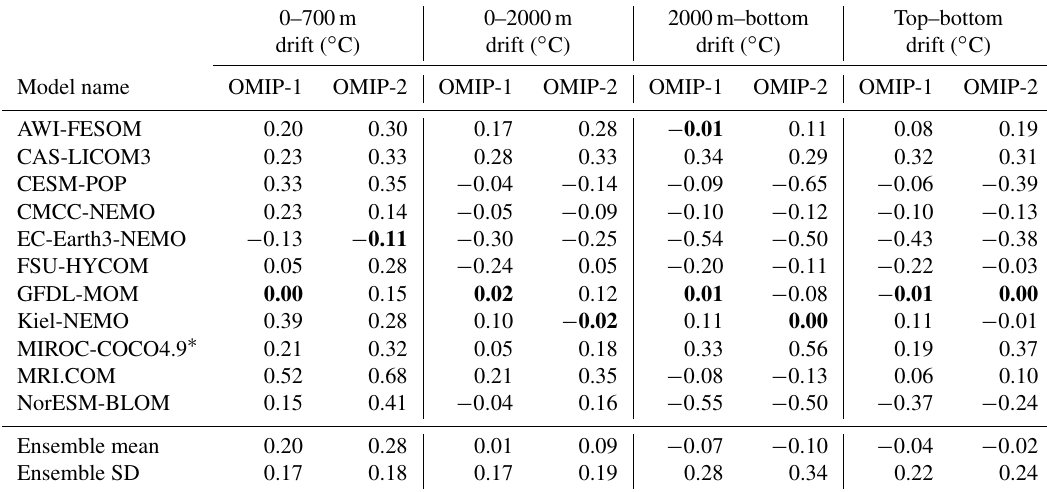
Table D1. Drift of vertically averaged temperature ( ◦ C) evaluated as the deviation of the 1980–2009 mean of the last cycle relative to the annual mean of the initial year of the simulation by each model for four depth ranges. The smallest drift values for models in each simulation are emphasized with bold